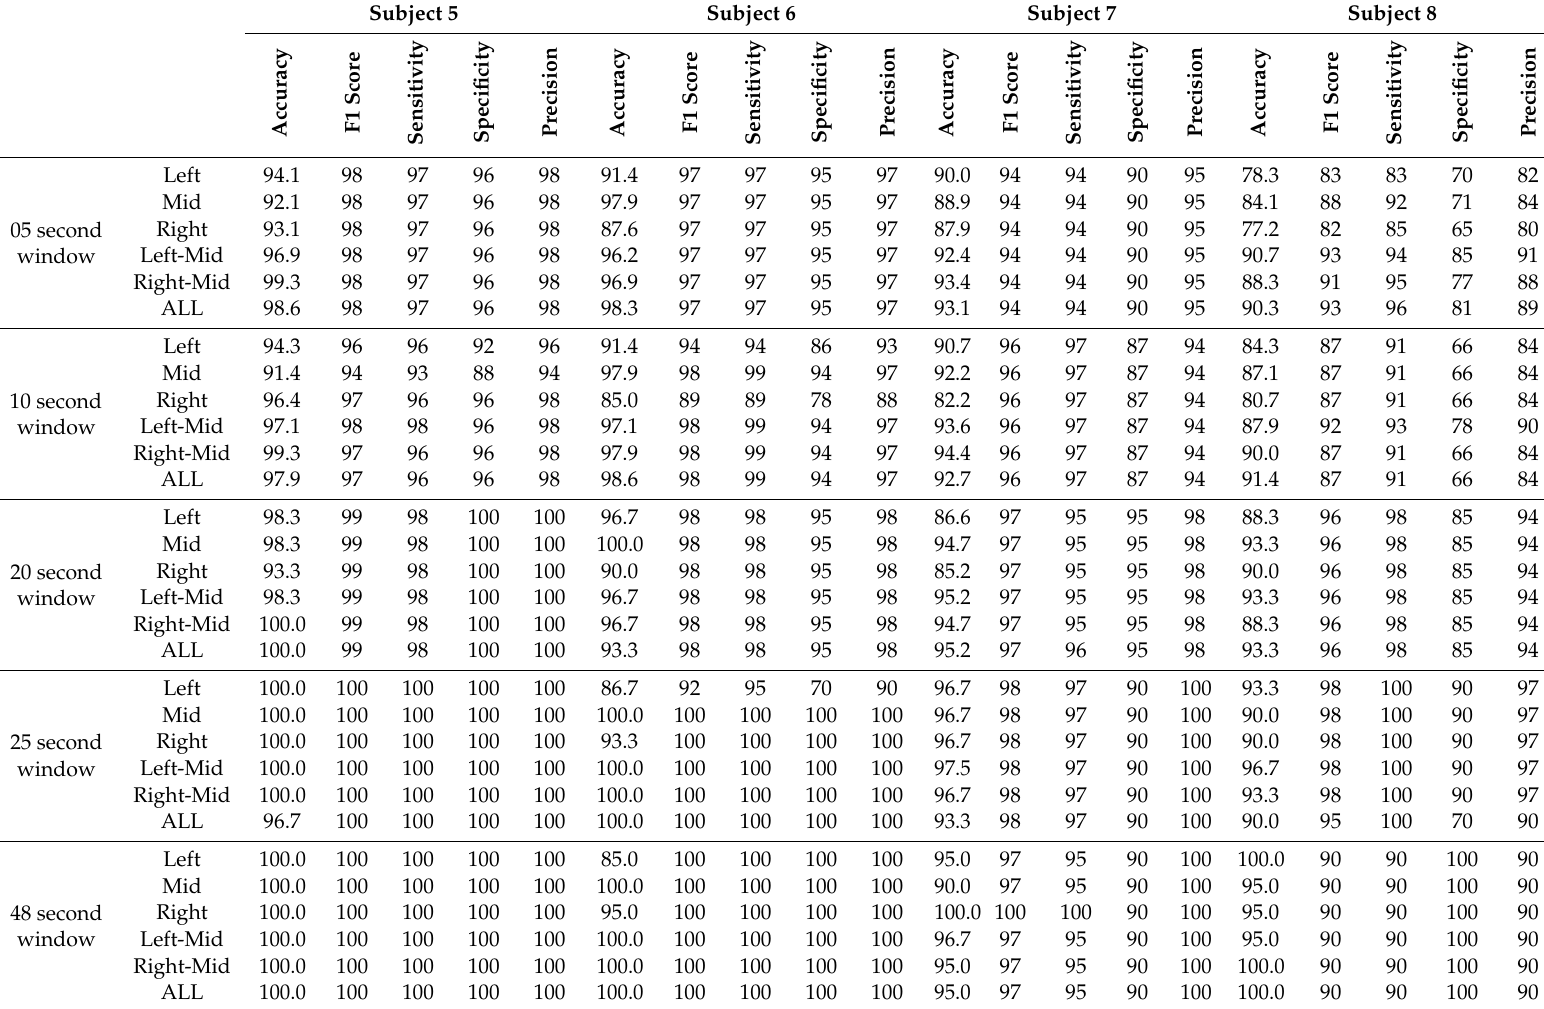
Table A2. Details of Classifiers ( Subjects